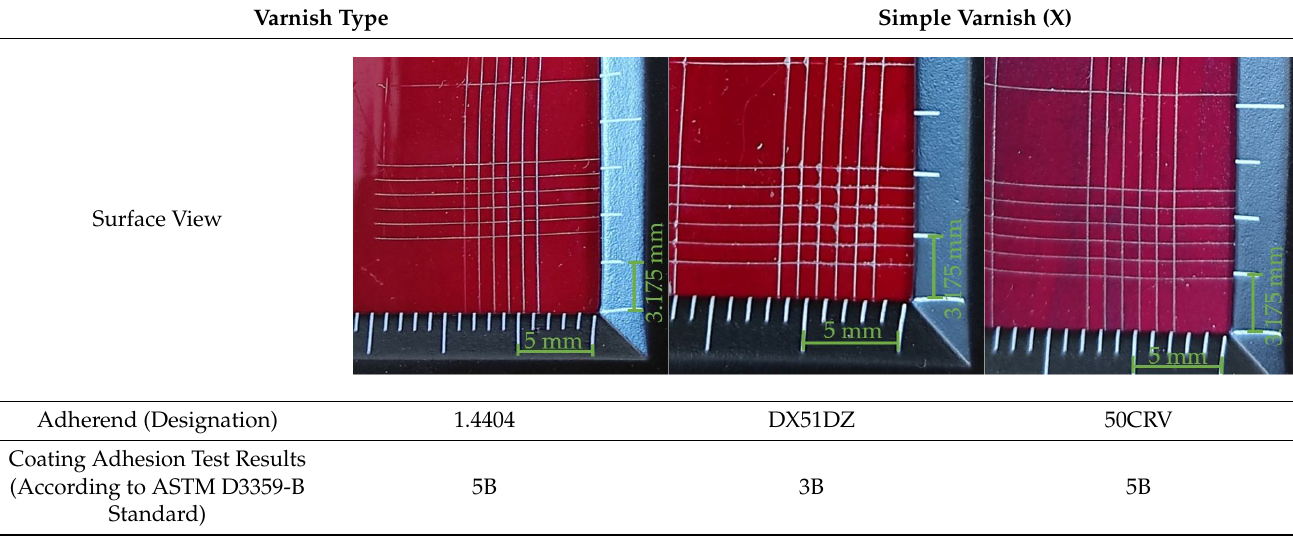
Table 9. Test results for the adhesion measurement of coatings to the substrate—simple varnish (X).